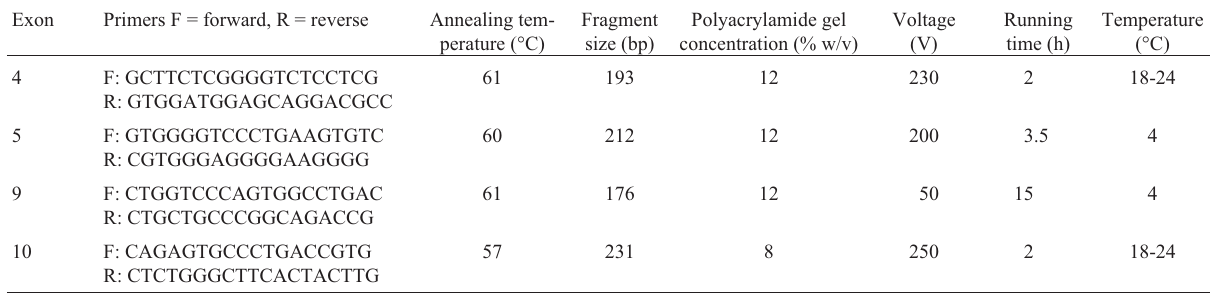
Table 3 - Type and frequency of N-acetylgalactosamine-6-sulfate sulfa- tase ( GALNS ) mutations in Brazilian patients with mucopolysaccharidosis IVA (MPS IVA), all presenting with a severe phenotype. The mutations were detected in the present study and by Tomatsu et al. (2004a) † . Of the